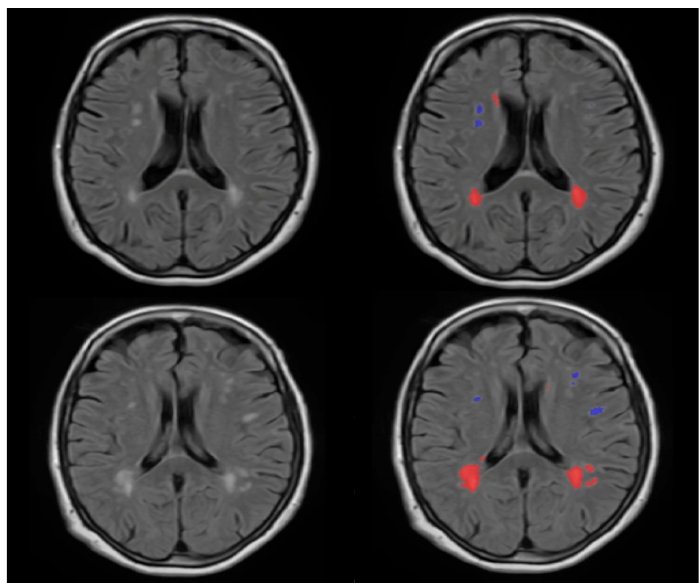
Figure 2. FLAIR MRI imaging of 69 years old female dizygotic twins (left column); the right side column pictures show the segmented version of the FLAIR images. The difference in the anatomy and number of WMH of the cut is visible in this image. According to our analysis, one twin has a total number of 24 WMHs (first row) and the other pair has a total number of 33 WMHs (second row). The red color represents the periventricular WMH and the blue color represents the juxtacortical WMH—image from the Semmelweis University Medical Imaging Centre.